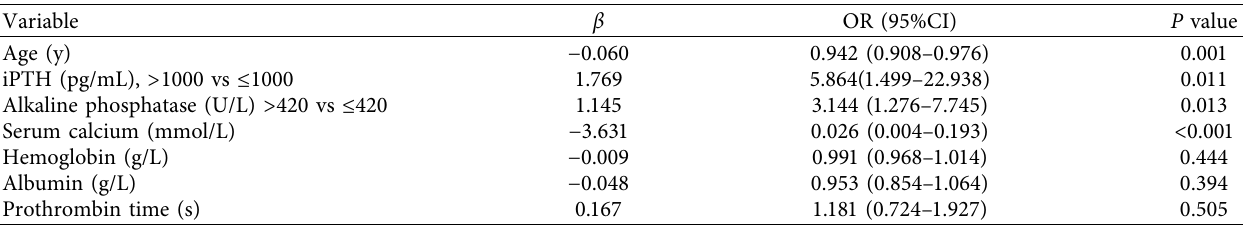
Table 3: Multivariate logistic regression analysis of SH presence based on preoperative data in the training cohort.